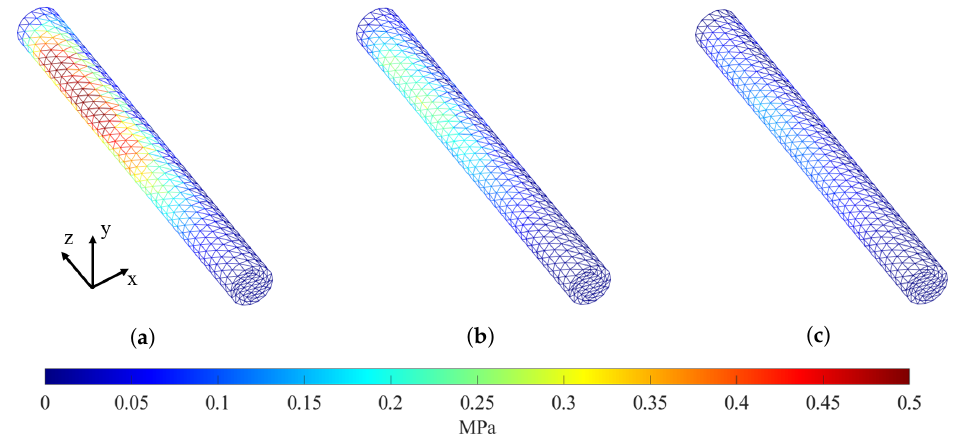
Figure 9. The error contour of the von Mises stress of the different error tolerance e i = 10%, 1%, and 0.1% for t = 6.04 s. ( a ) e i = 10%; ( b ) e i = 1%; ( c ) e i =